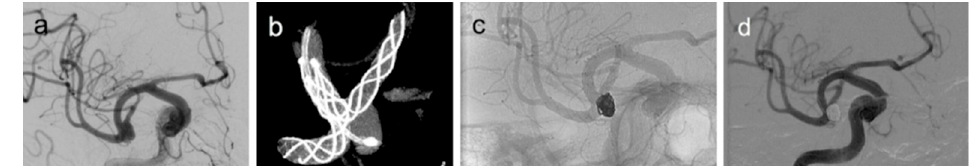
treated with the Y-stenting technique using two LVIS Jr and jailed microcatheter technique visible on intraprocedural contrast-enhanced flat panel detector CT (MIP reconstruction); ( c ) final unsubtracted angiogram demonstrates the markers and radiopaque strands within the body of the stents; ( d ) post- procedural DSA showing complete occlusion of the aneurysm.